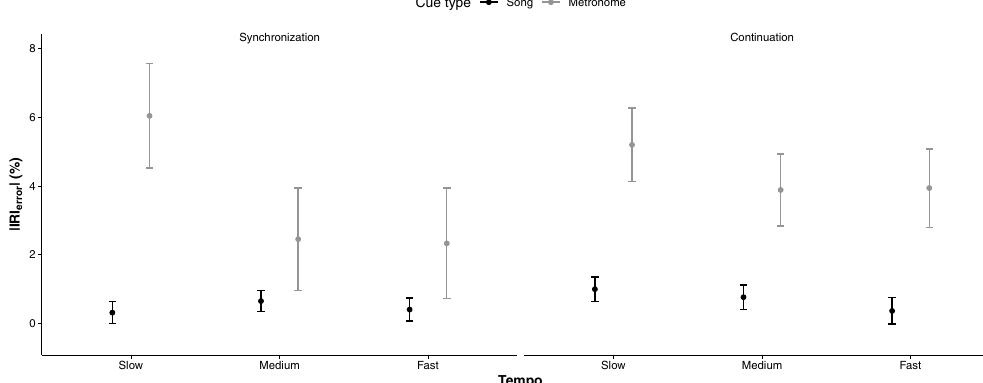
Figure 4. Entrainment to the pace of regular time intervals. Mean |IRI error | in % for each tempo (slow, medium, fast) and section (synchronization, continuation) as a function of cue type (song, metronome). 95% CIs are represented in the figure by the error bars attached to each mean point.